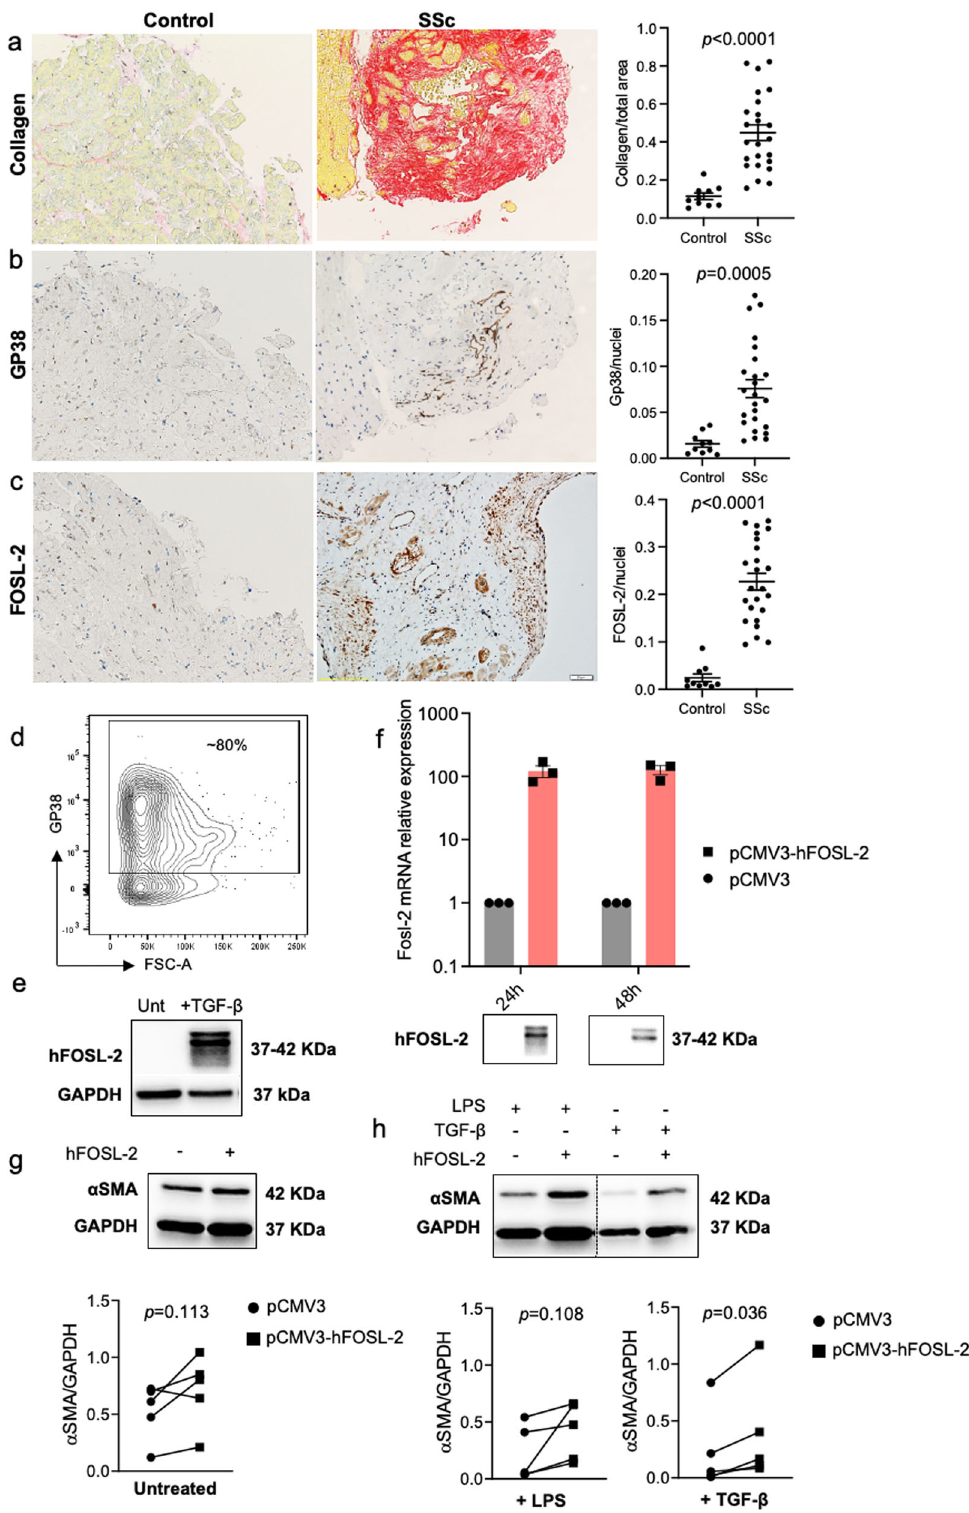
Fig. 7 GP38 and FOSL-2 expression in human specimens. Representative pictures and relative quanti fi cation of Sirius red ( a ), GP38 IHC ( b ), and FOSL-2 IHC ( c ) staining of EMBs from HF/SSc patients and donors with healed myocarditis ( n = 10 – 24, unpaired t -test, mean ± SEM, scale bar: 20 µ m). d Representative fl ow cytometry plot of GP38-expressing human foetal cardiac fi broblasts (fCFs). Panel e illustrates representative immunoblots of FOSL-2 in fCFs in response to treatment with TGF- β (10 ng/mL) for 24 h. f hFOSL-2 overexpression in fCFs assessed by qPCR and WB analysis ( n = 3, mean ± SEM). Panels g and h show representative immunoblots and WB analysis of fCFs transfected with pCMV control and pCMV-FOSL-2 vectors at basal condition in 10% FBS DMEM (F) and after stimulation with TGF- β or LPS for 24 h (G) (all paired t-test , n =